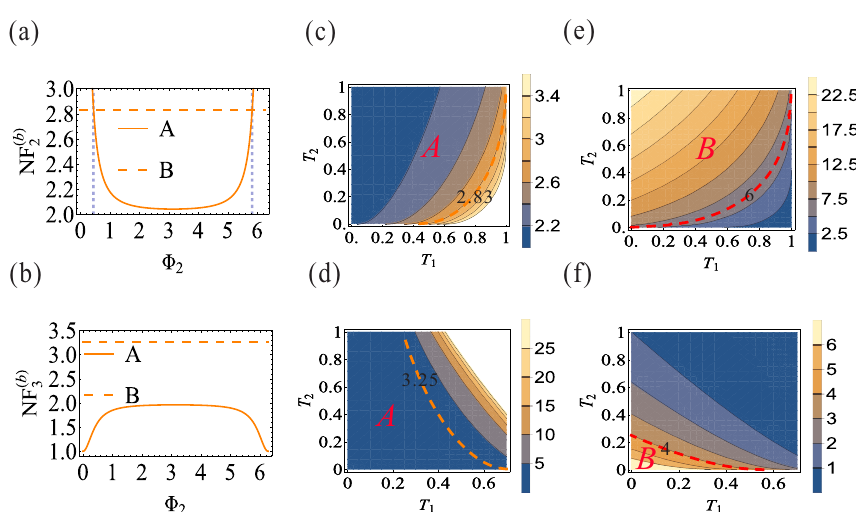
( b ) ( b ) Figure 3. The dependence of NF and NF in Equation (6) on Φ 2 under the condition of T 1 = 0 2 3 and T 2 = 1 (traces A in ( a , b )), and T 1 and T 2 under the condition of Φ 2 = π ( Φ 2 = 0) in ( c , d ). The ( b ) ( b ) dependence of G and G in Equation (7) on T 1 and T 2 under the condition of Φ 2 = π ( Φ 2 = 0) in 2 3 ( e , f ). The vertical blue dashed lines in ( a ) are Φ 2 = ( 1.05, 5.24). See Figure 2 for